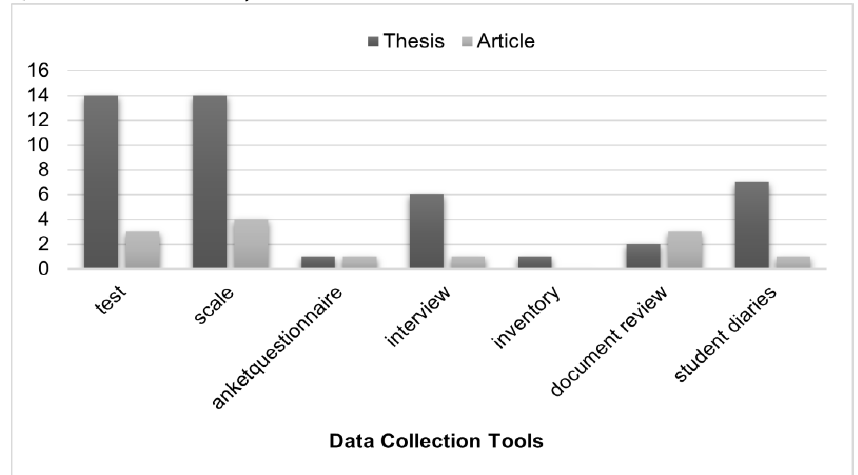
Figure 7: Distribution of Studies by Data Collection